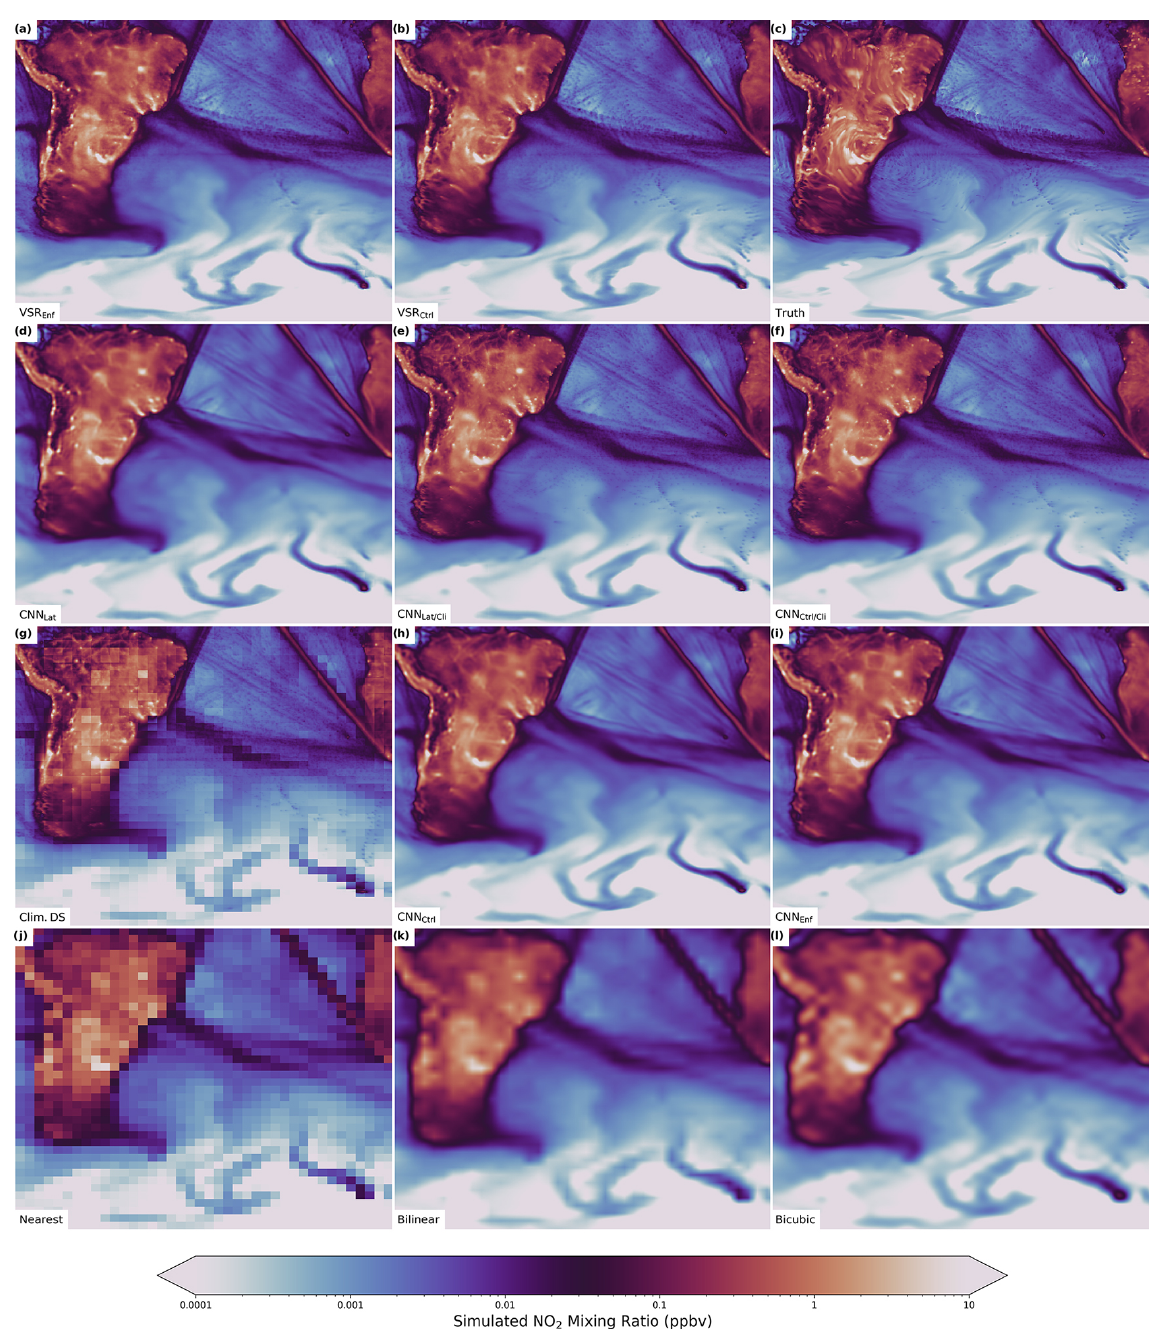
Figure 4. Super-resolved NO 2 concentrations for 11:30Z on 20 July 2020 in the simulation from 70.25–4.75 ◦ S and 75–225 ◦ E.